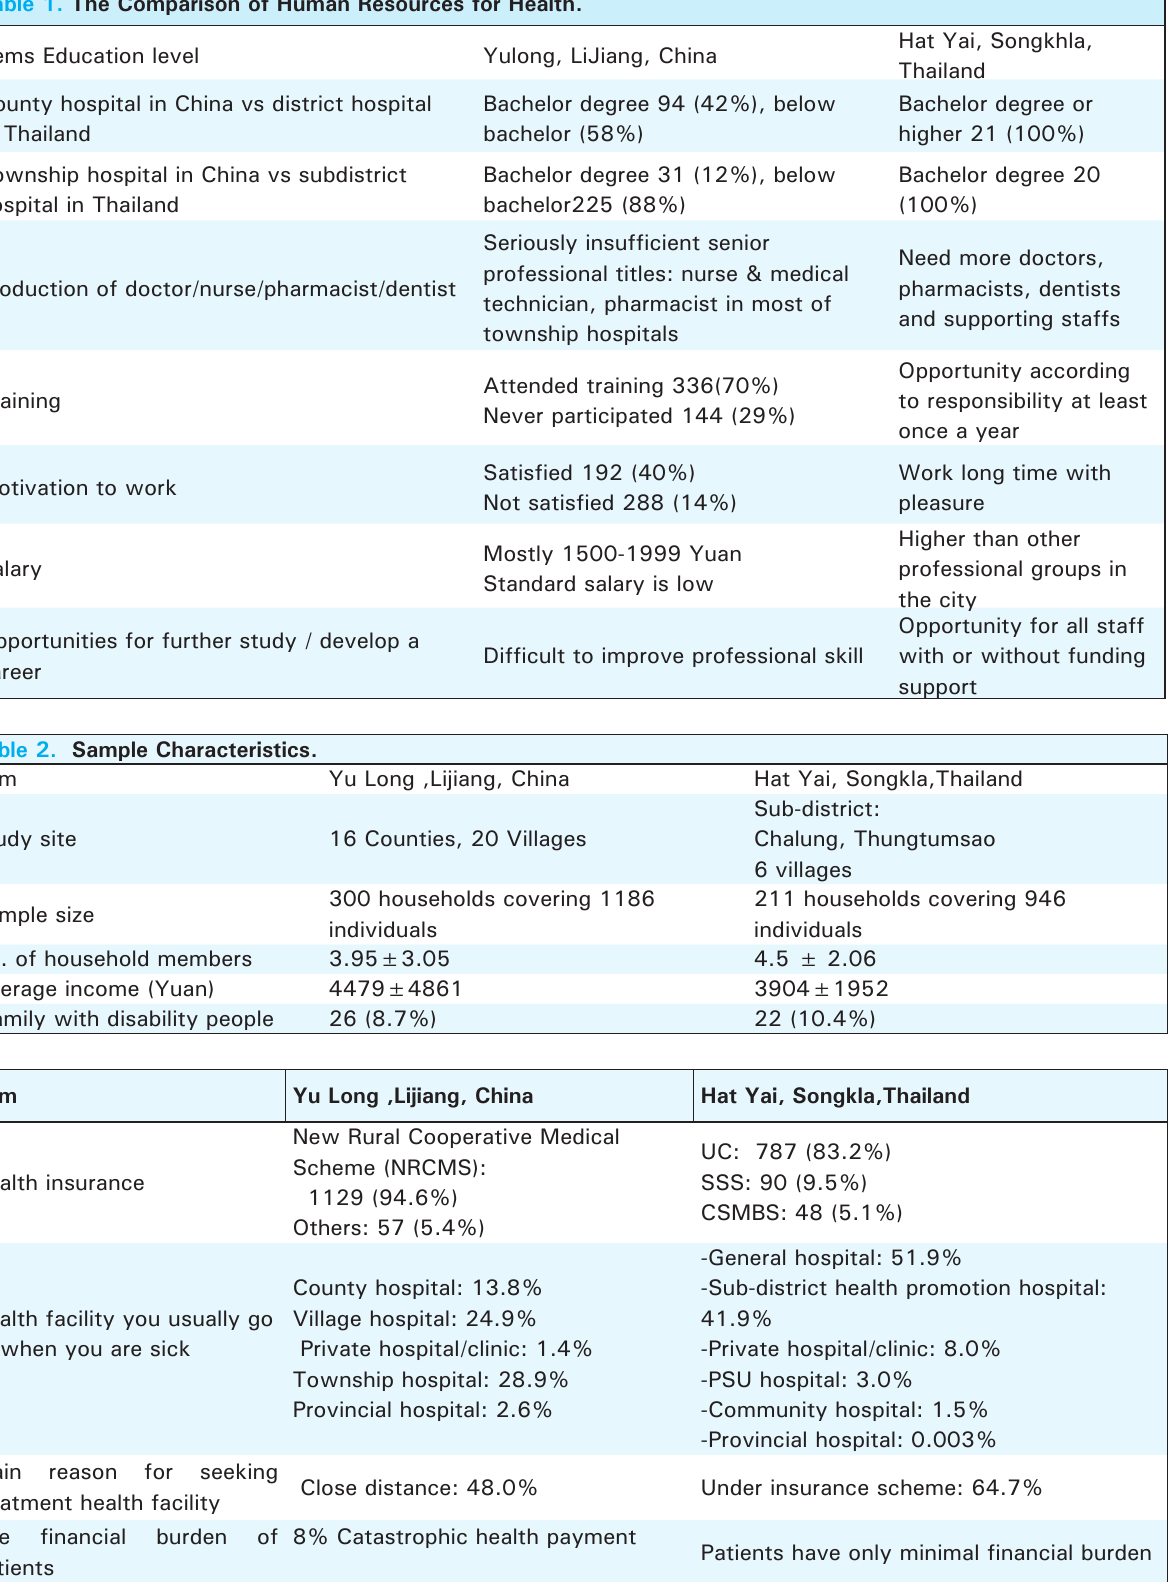
Table 1. The Comparison of Human Resources for Health.